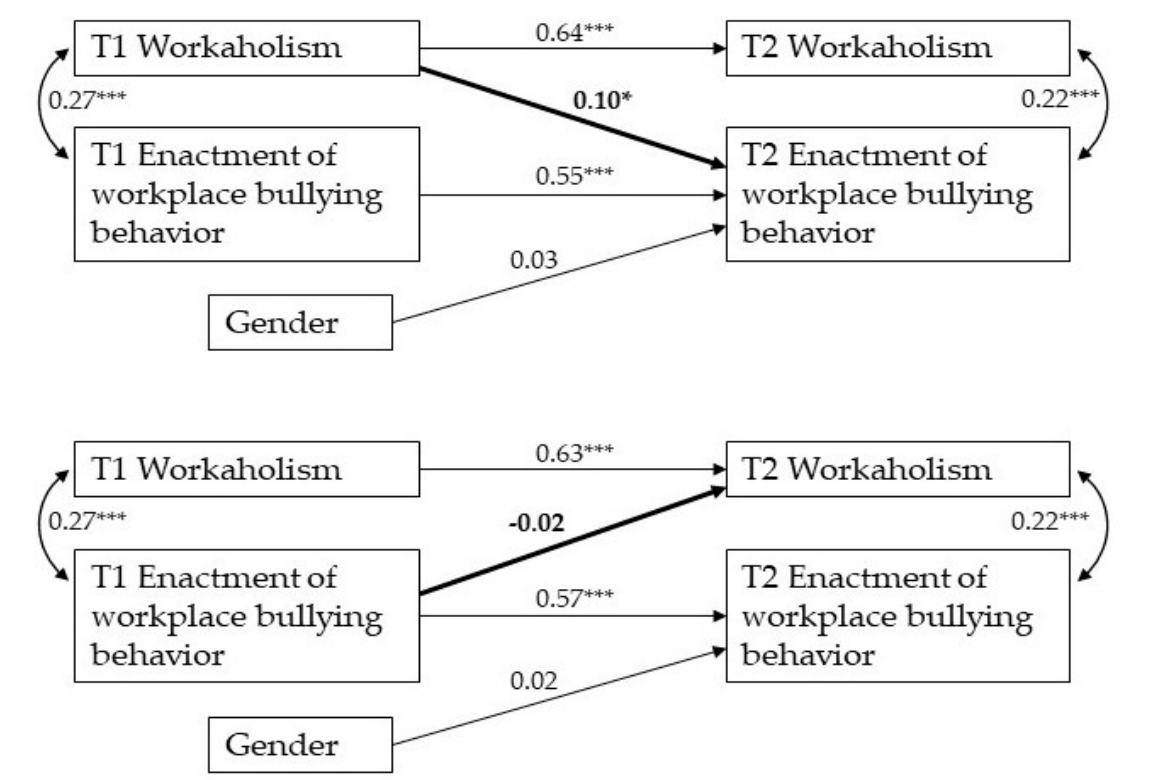
Figure 1. Path analysis in Model 2 (above) and Model 3 (below) of the cross-lagged relationships between workaholism and enactment of workplace bullying behavior. * p < 0.05, *** p < 0.001.